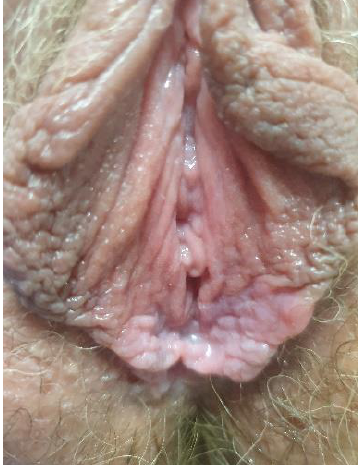
Figure 21. Vulvar HSIL. (after the application of acetic acid).